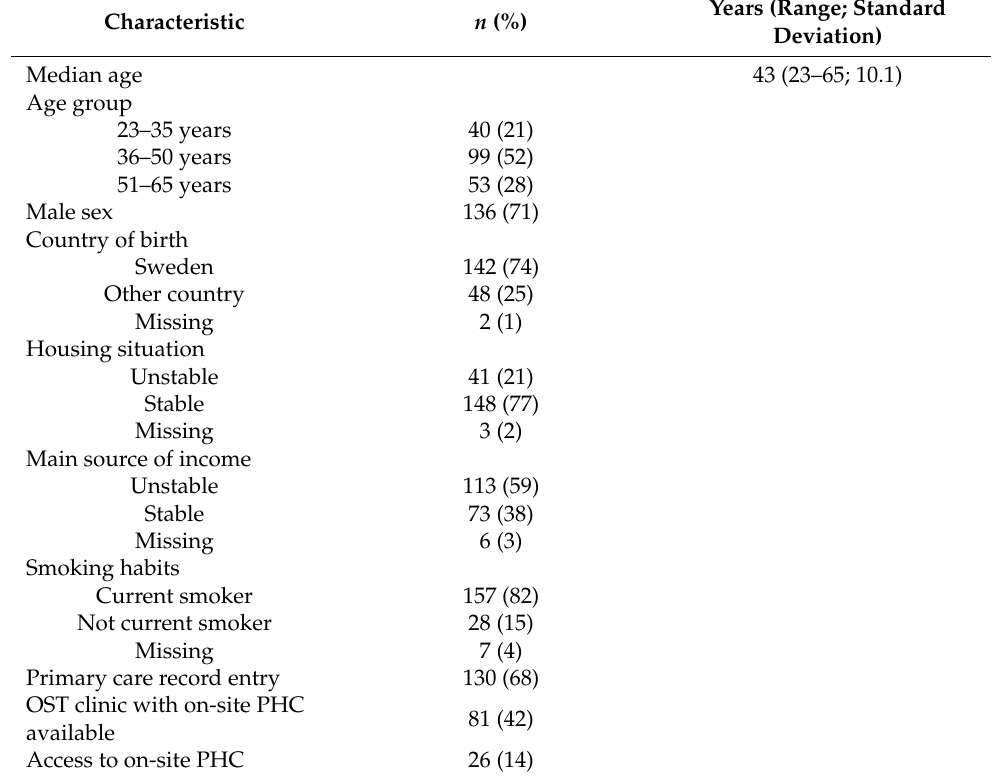
Table 1. Sample characteristics. n =